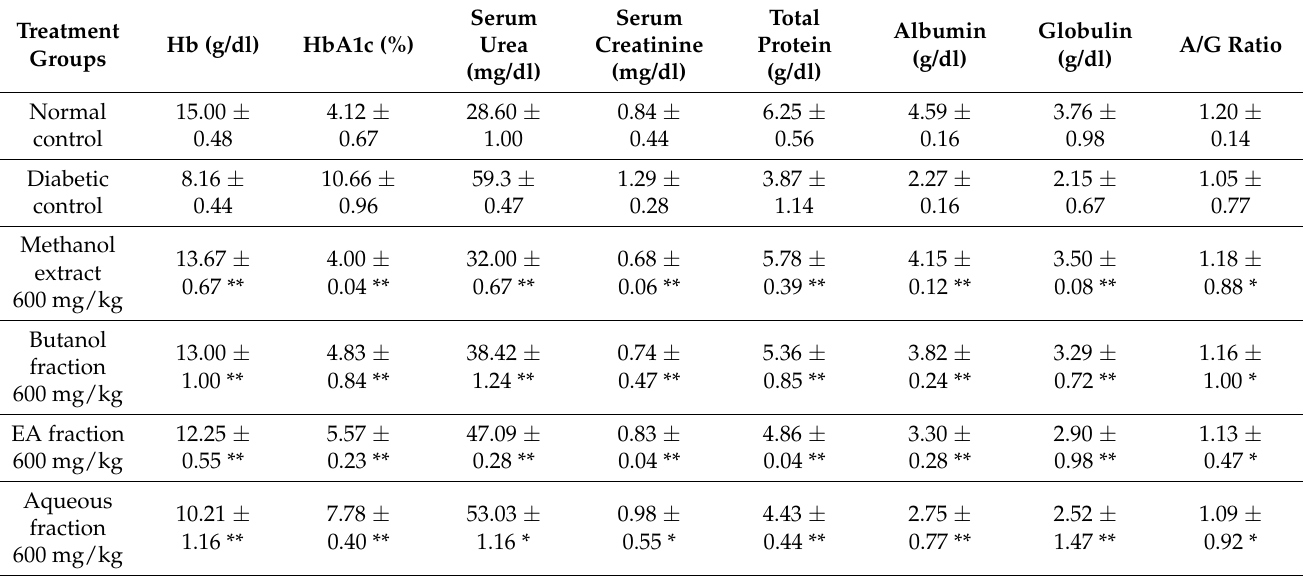
Table 9. Effect of B. calliobotrys on biochemical parameters on 42nd day